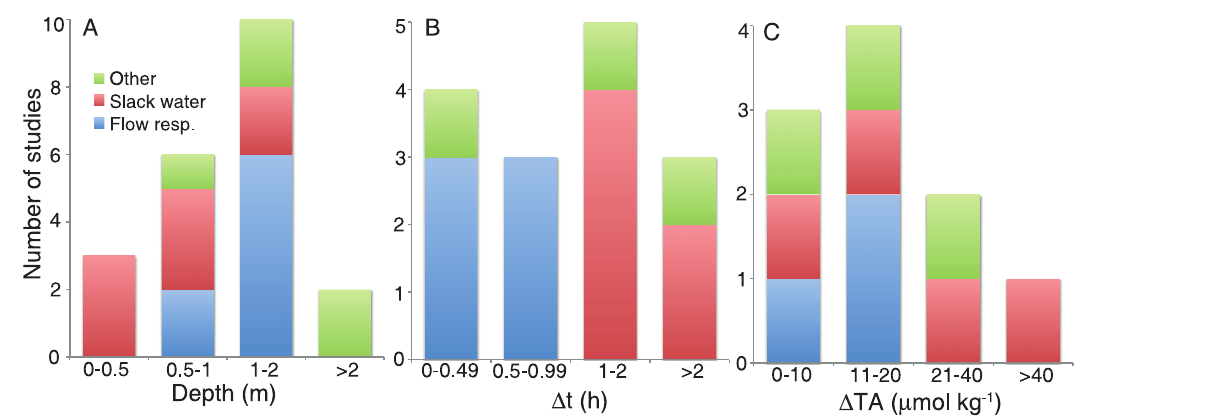
Figure 3. Summary of mean (A) depth (B) duration and (C) change in TA of metabolic studies using flow respirometry, slack water and other in situ methods of calculating net community calcification. Data is only shown for published studies in which mean parameters were provided or could be calculated. See Table S1 for the full dataset and further